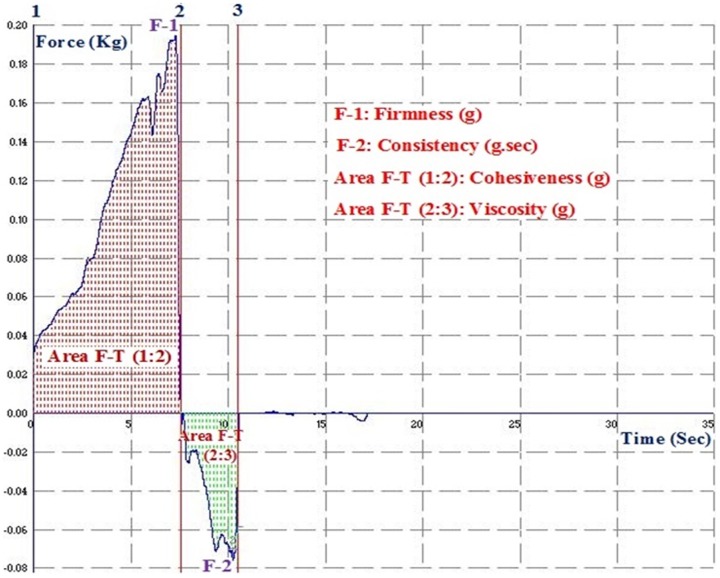
Typical graph representing the texture analysis of a gel.